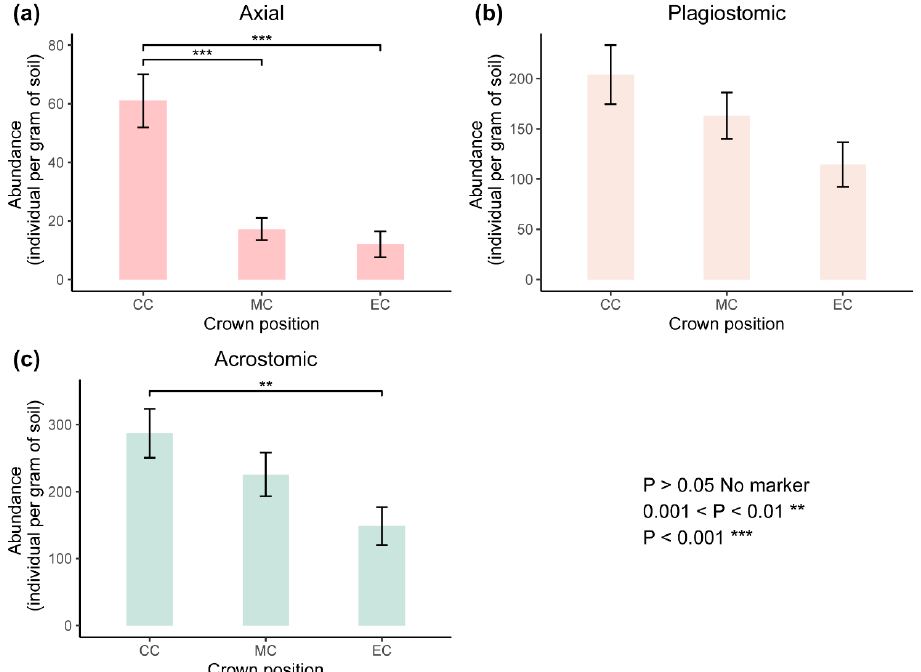
Figure 6. Overall community characteristics (mean ± SE) of the TA communities under the three crown positions (CC — the center of the crown, MC — the middle of the crown, EC — the edge of the crown) [( a ) The abundance of TA communities at the three crown positions; ( b ) The species richness of TA communities at the three crown positions; ( c ) The Shannon’s diversity index of TA commu- nities at the three crown positions; ( d ) The Pielou’s evenness index of TA communities at the three crown positions].